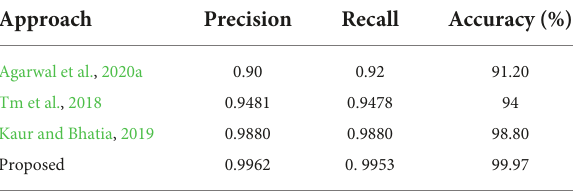
TABLE 5 Comparison with the latest